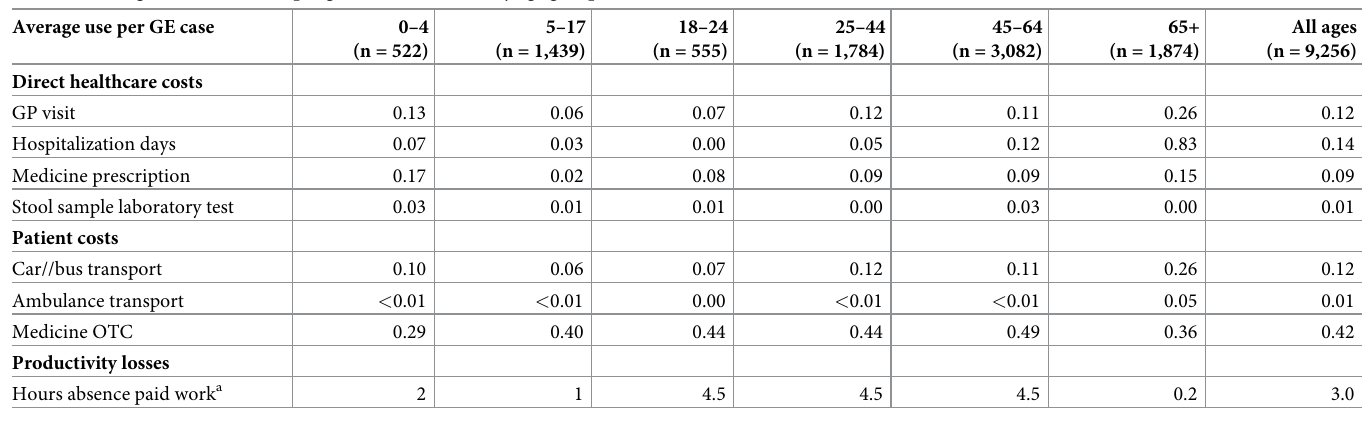
Table 4. Average use of resources per gastroenteritis case, by age group.